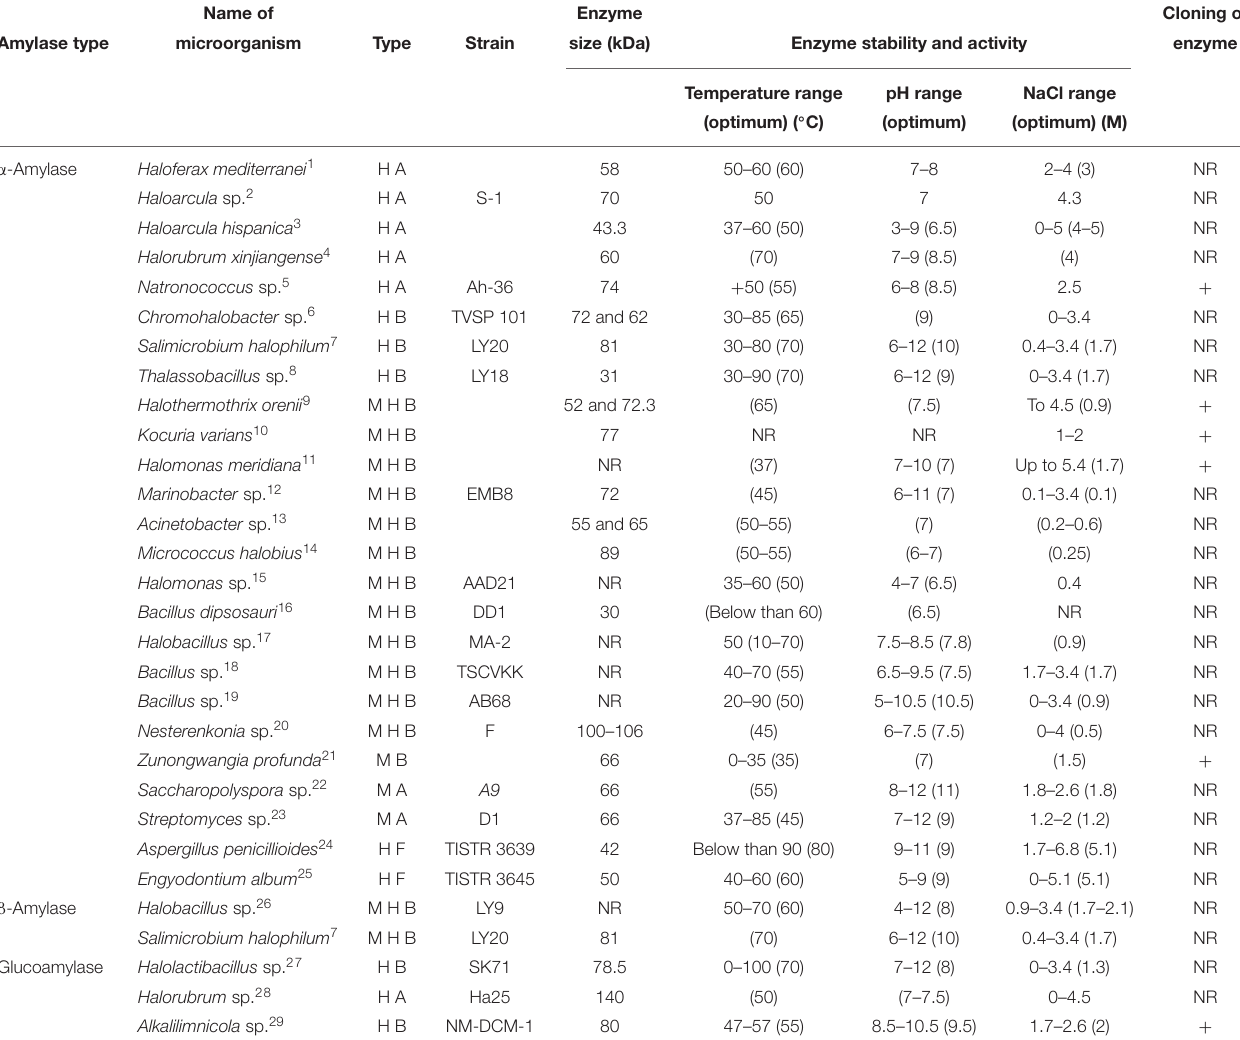
TABLE 1 | Amylase enzymes ( α -amylase, β -amylase and glucoamylase) from halophilic microorganisms ∗